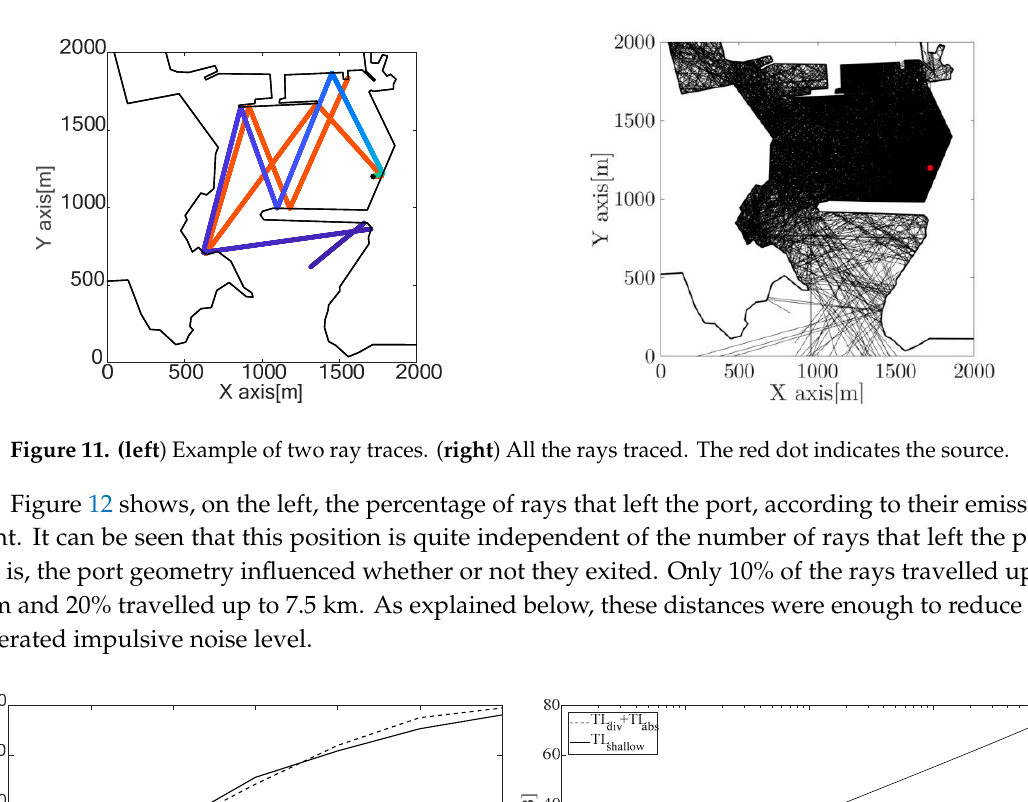
Figure 11. (left ) Example of two ray traces. ( right ) All the rays traced. The red dot indicates the source.